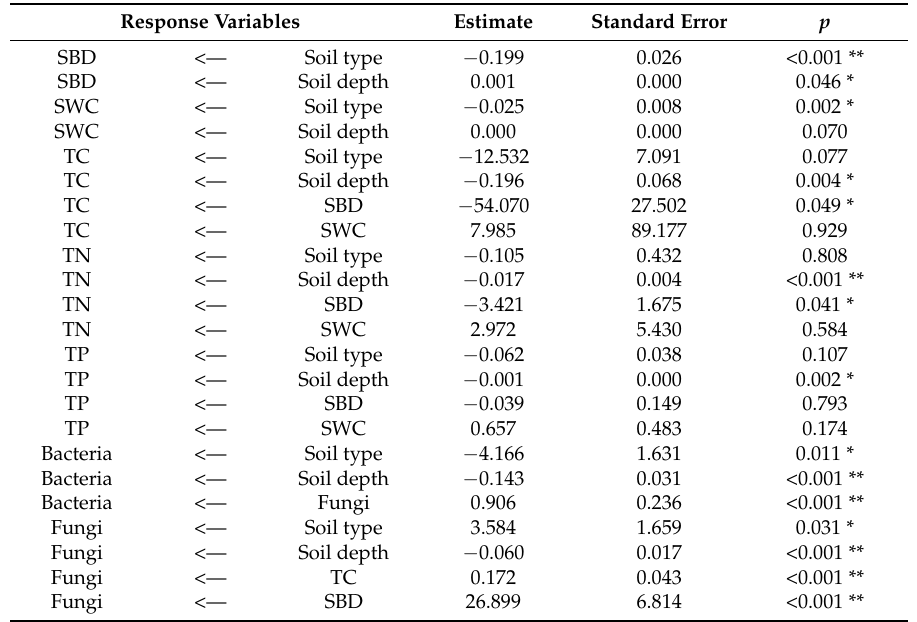
Figure 4. Structural equation modeling on the direct and indirect effects of soil type and soil depth on soil bulk density (SBD) and soil water content (SWC) on the contents of soil total carbon (TC) , total nitrogen (TN), and total phosphorus (TP), and soil microbial biomass (soil bacterial biomass and fungal biomass). The final model fit the data well: χ 2 = 8.193, df = 10, GFI = 0.946, RMSEA < 0.001, p = 0.610. Numbers at solid arrows ( p < 0.05) were standardized path coefficients, and width of the arrows indicated the strength of the relationships. The dashed arrows indicated nonsignificant relationships ( p > 0.05). Numbers close to variables ( R 2 ) indicated the variance explained by the model. Here df, GFI and RMSEA mean degree of freedom, goodness of fit index, root-mean square error approximation, respectively. Table 3. Regression weights and covariance in the structural equation model.